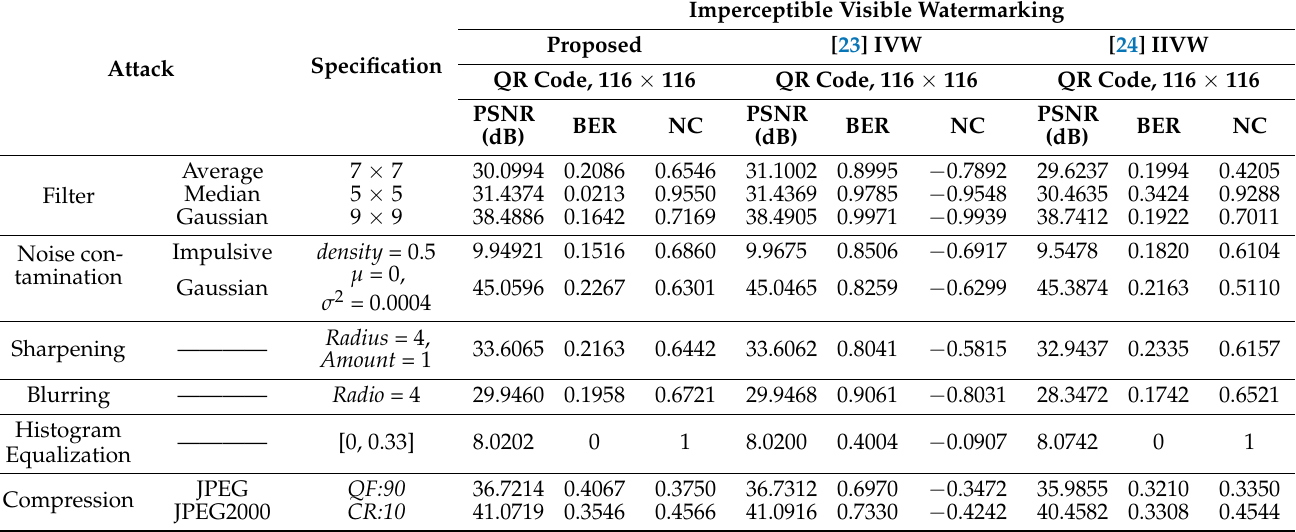
Table 9. Robustness comparison against image processing